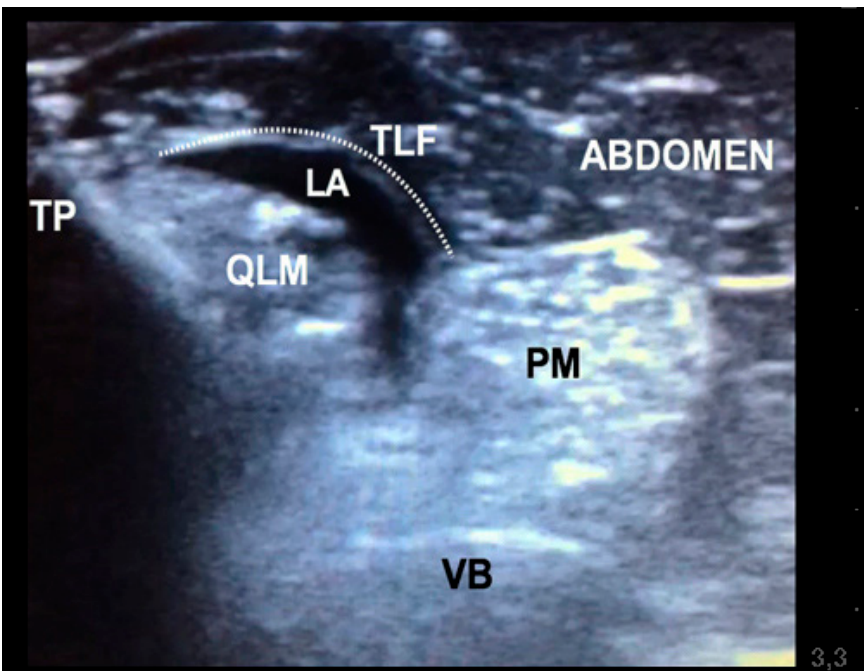
Figure 3. Ultrasound image obtained after injection in a canine carcass during quadratus lumborum block (QLB). The picture shows hydrodissection of the quadratus lumburom muscle from the psoas muscle and the thoracolumbar fascia, illustrating that the QLB block was successful. TP, transverse process of L2 vertebrae; VB, vertebral body of L2 vertebrae; QLM, quadratus lumborum muscle;